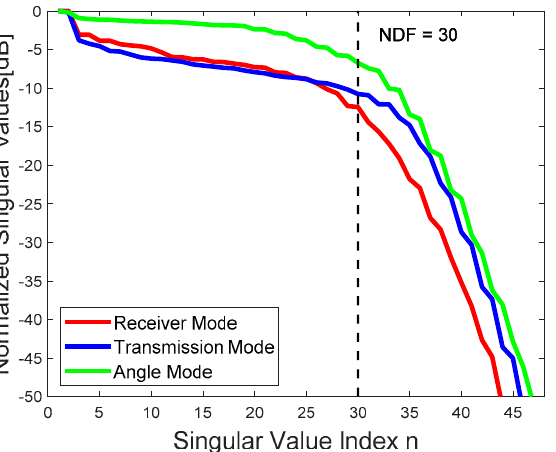
Figure 3. Comparison of the behavior of the normalized singular values of the relevant operators for reflection, transmission, and angle modes.